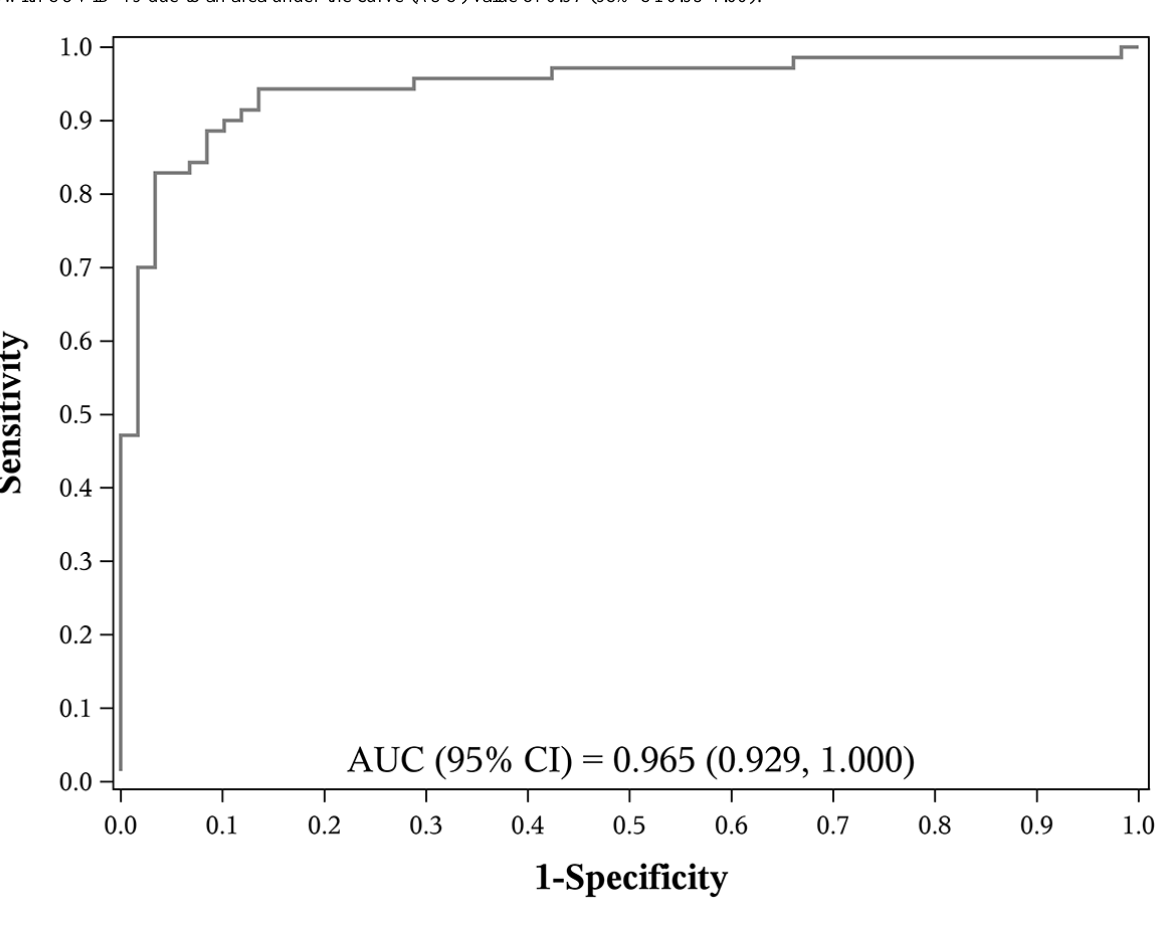
Figure 2. The receiver operating characteristic (ROC) curve of selected variables for COVID-19–positive cases. The ROC curve demonstrates the trade-off between sensitivity and specificity, and shows that the biomarker with a combination of selected variables is the most accurate test for identifying patients with COVID-19 due to an area under the curve (AUC) value of 0.97 (95% CI